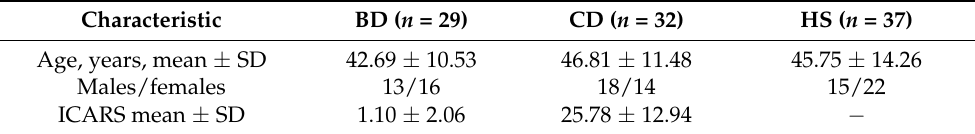
Table 1. Main demographic and clinical characteristics of the BD, CD and HS